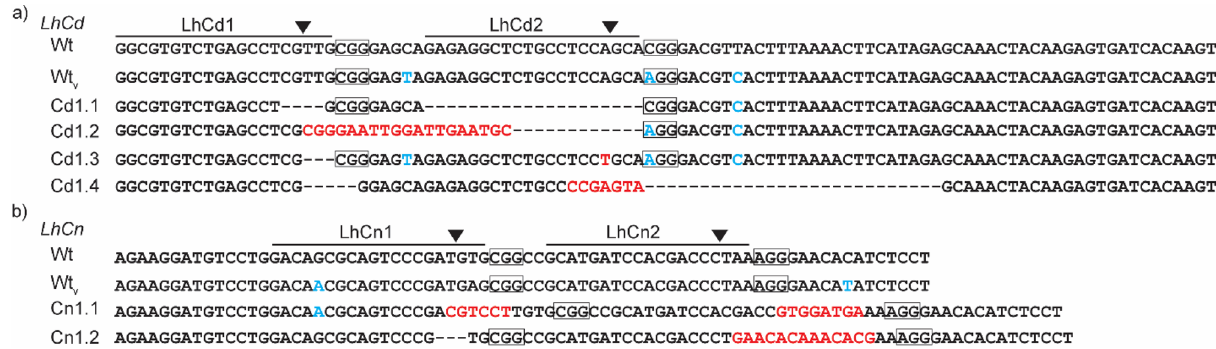
Figure 4. Intergenerational LhCd and LhCn mutations in Lygus hesperus CRISPR/Cas9 mutant strains. Multiple sequence DNA alignments of intergenerational LhCd ( a ) and LhCn ( b ) mutations with the corresponding wild-type (Wt) sequences. Aligned regions of LhCd and LhCn only include sequences near the sgRNA target sites (LhCd1-2 and LhCn1-2). A variant allele within the wild-type sequences (Wt v ) is shown. Horizontal lines indicate the sgRNA sequences, boxes indicate the PAM sequence trinucleotides, arrowheads indicate the predicted Cas9 cut sites, blue text indicates allele variants, red text denotes substitutions or insertions, and (–) corresponds to a sequence